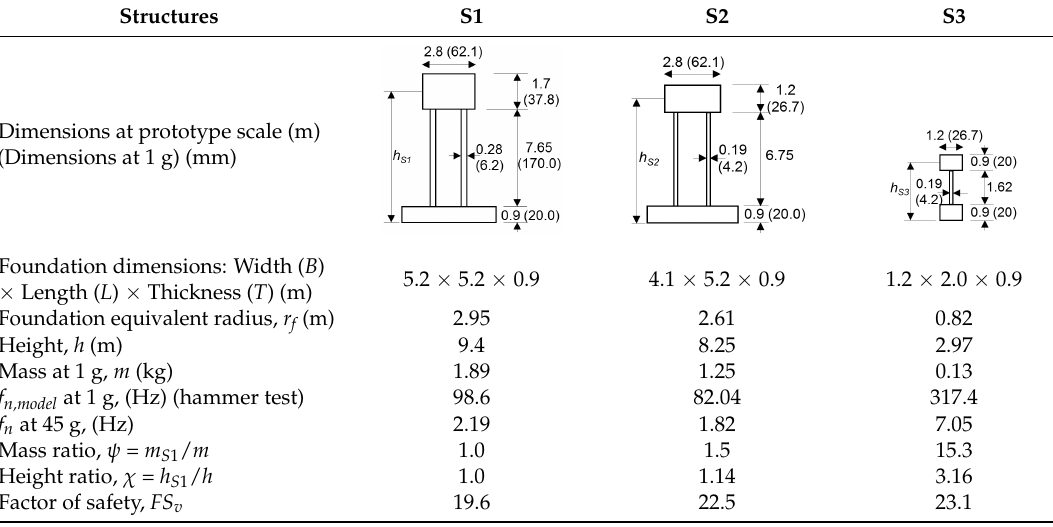
Table 1. Dimensions and characteristics of structural models.